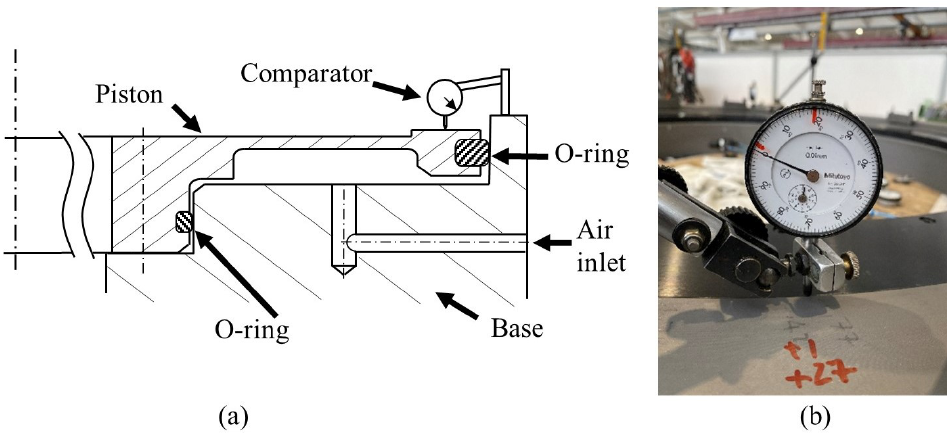
Figure 4. ( a ) Scheme of the experimental setup and ( b ) picture of the real experiment.